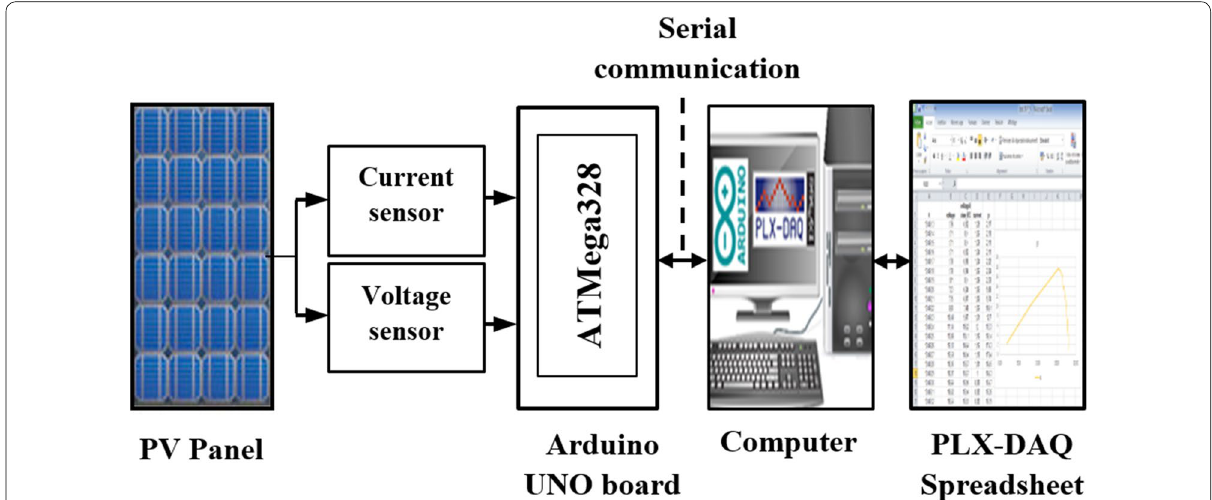
Fig. 4 Schematic of PV panel output characteristics instrumentation